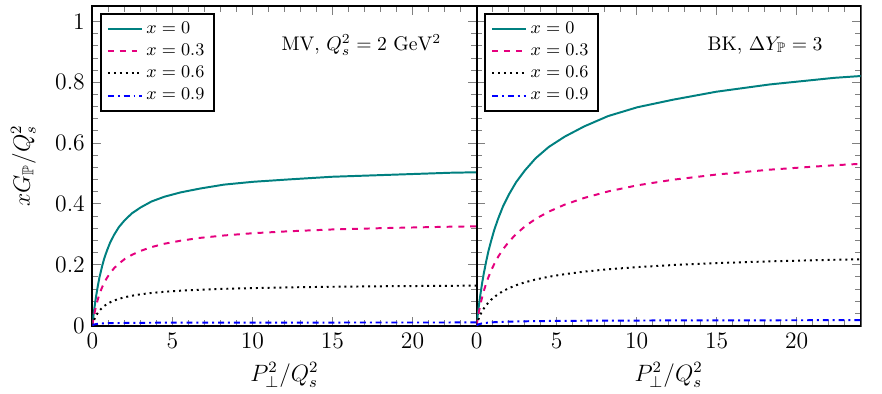
Figure 9 . The reduced Pomeron gluon distribution κ eq. (5.23), is plotted as a function of the rescaled momentum P 2 and 2 values of ∆ Y the MV model. Right panel: the result of the BK evolution up to ∆ Y from the solution to the BK equation with the initial condition at ∆ Y